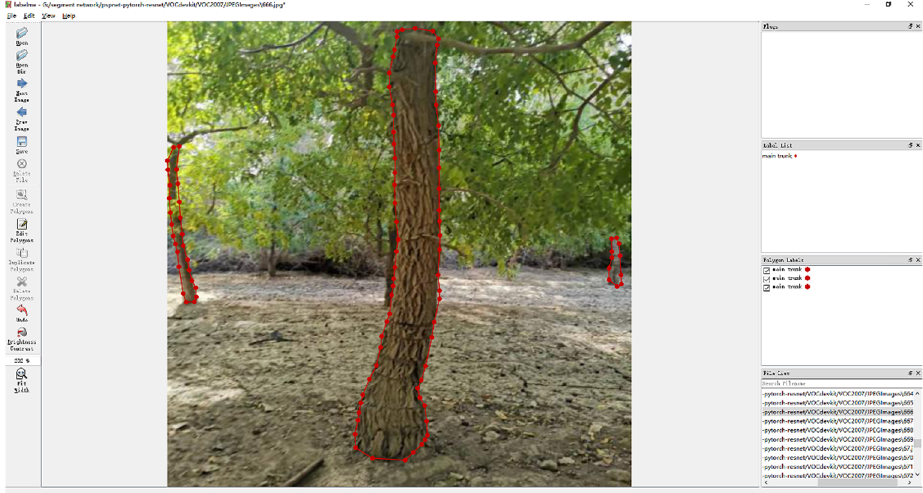
Figure 3. Labelme image annotation.